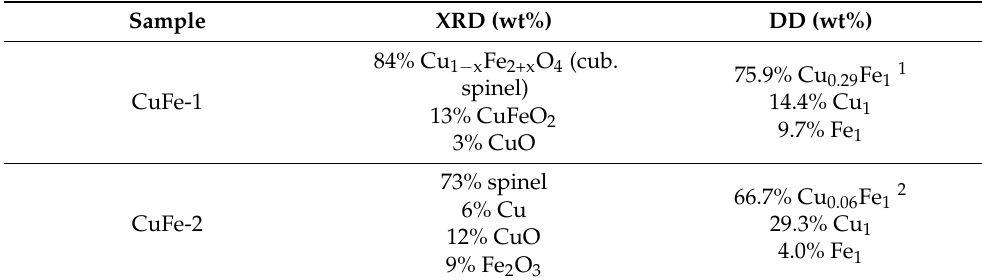
Table 3. The comparison the phase composition of CuFe-1 and CuFe-2 according to the results of X-ray diffraction method (XRD) and differential dissolution